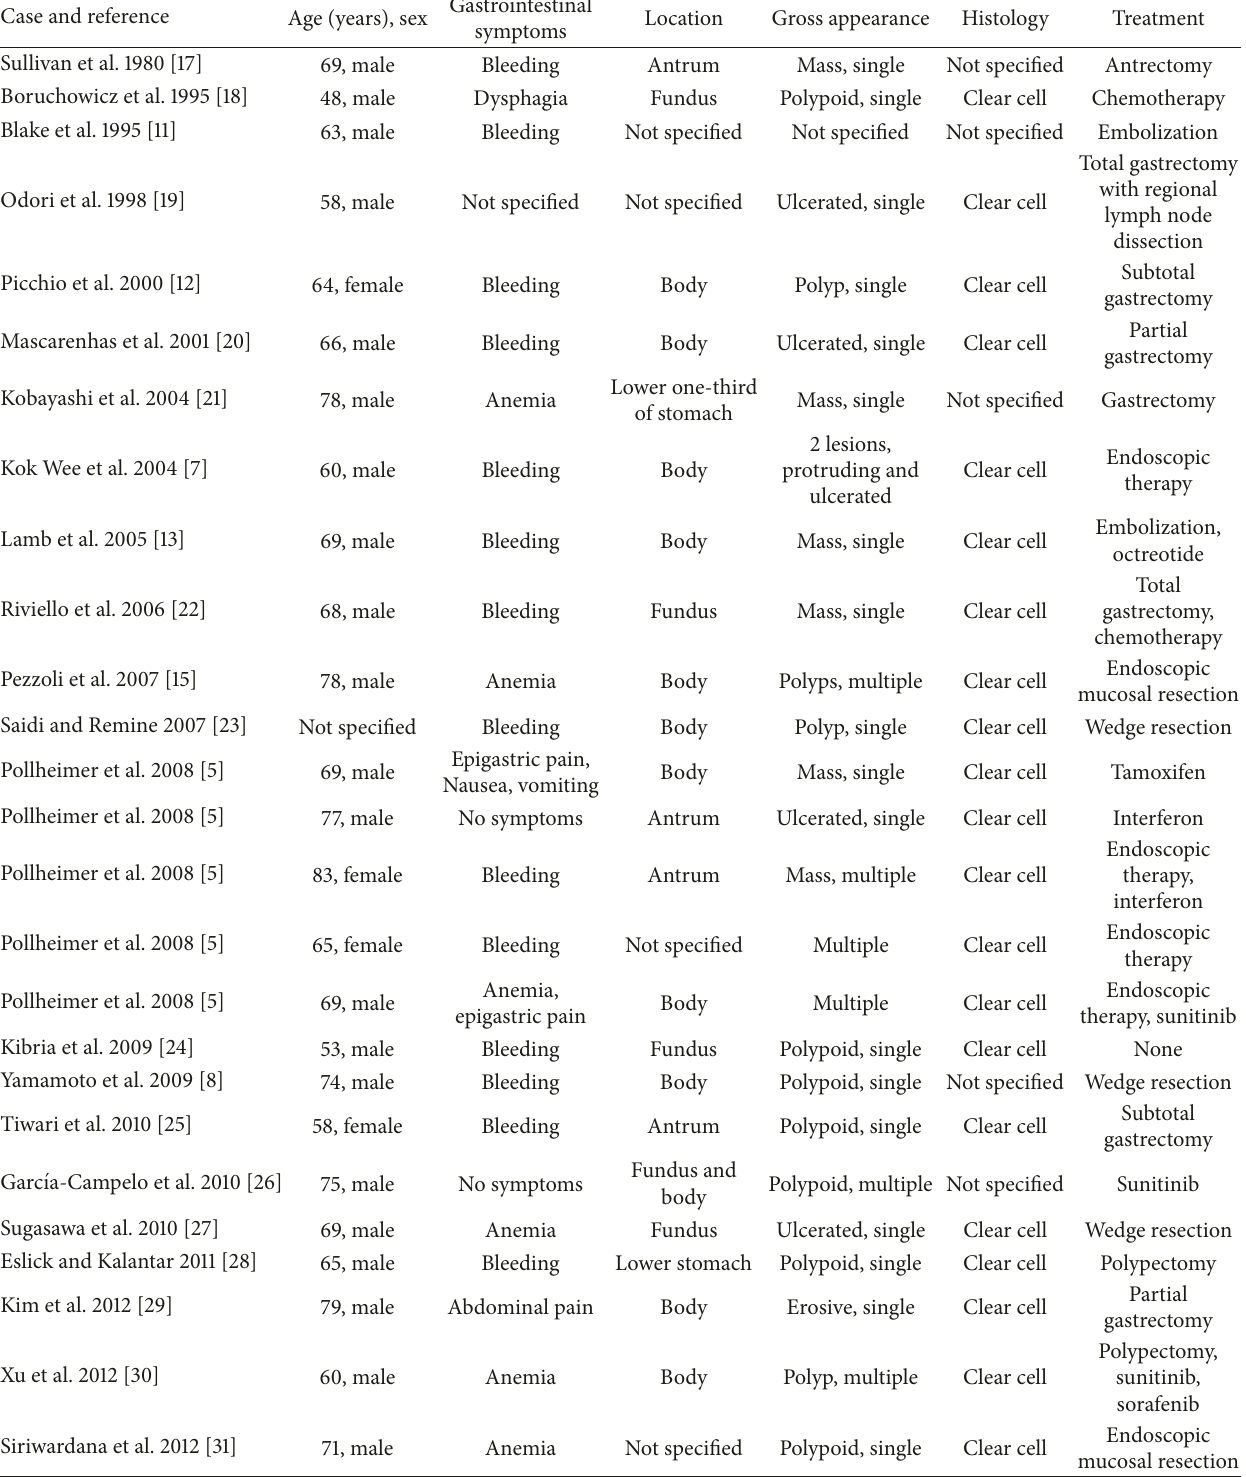
Table 1: Reported cases of gastric metastases from RCC in English